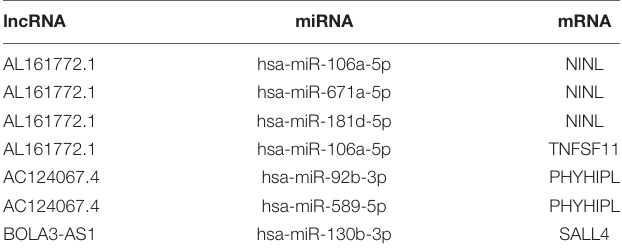
TABLE 2 | The genome instability-related competing endogenous RNA network in